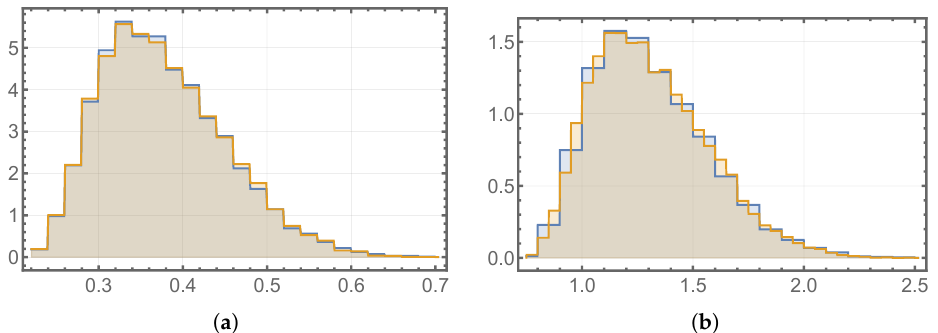
Figure 15. Distributions of the quantities of interest of the Monte Carlo (Orange) and sampled Galerkin (Blue) solutions. The agreement is excellent. The x -axis is the observed value and the y -axis is the normalized pseudofrequency; the area under the graph is equal to one. ( a ) L 2 ( u 1 ) : Monte Carlo convergence and ( b ) L 2 ( u 2 ) : Monte Carlo